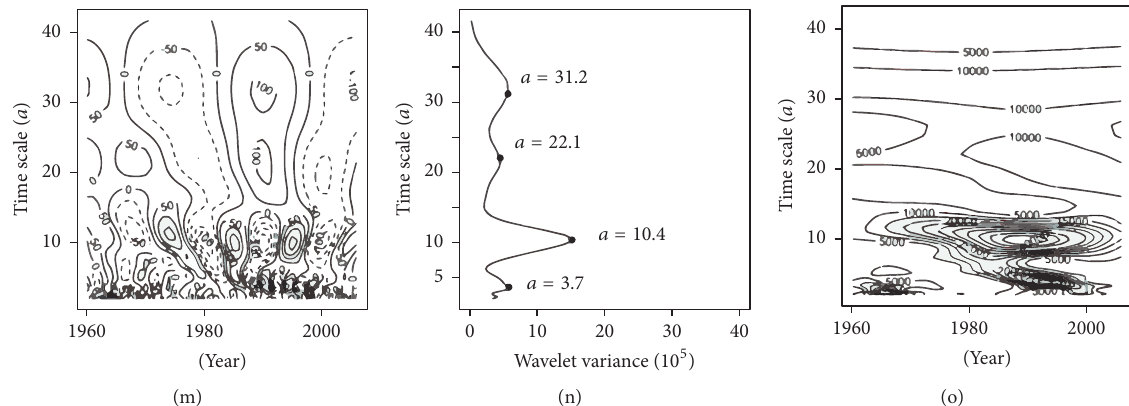
Figure 7: Real part (a, d, g, j, and m), wavelet variance (b, e, h, k, and n), and modulus square (c, f, i, l, and o) of wavelet transformation coefficients for annual precipitation in four subregions (Liaodong Peninsula, (a–c); Northeastern Mountain, (d–f); Western Highland, (g–i); and Central Plain (j–l)) and Liaoning (m–o) by using the Morlet Wavelet analysis.